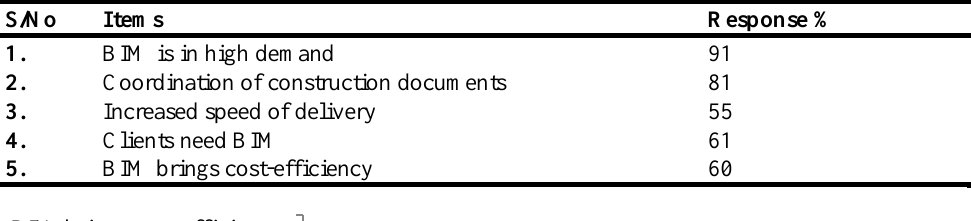
Table 1. Representation of the Benefits of the Use of BIM (National BIM Report, 2019)